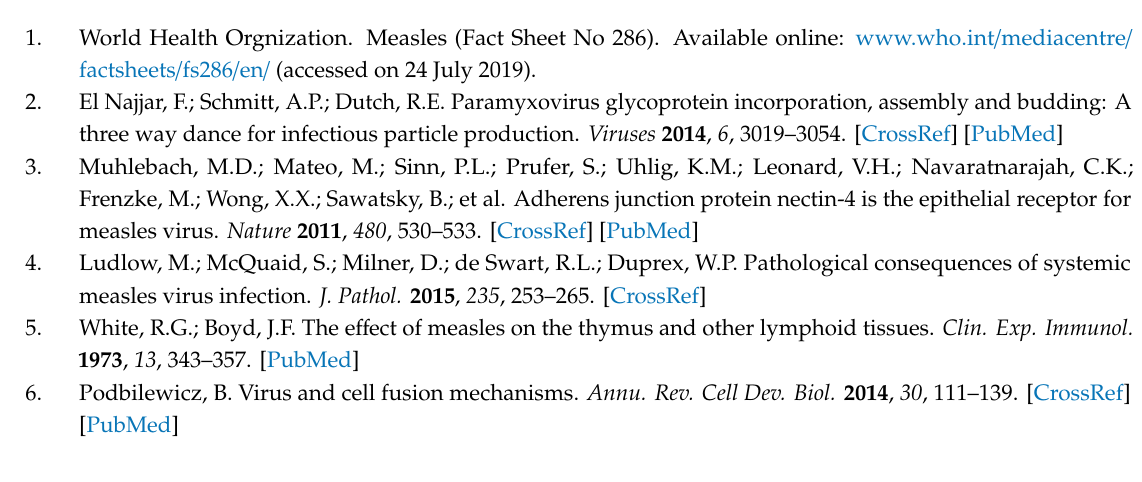
Figure S1: MeV entry is not inhibited by BST2, Figure S2: Incucyte analysis of MeV-GFP syncytia expansion, Figure S3: rLuc-GFP activity is not a ff ected by BST2